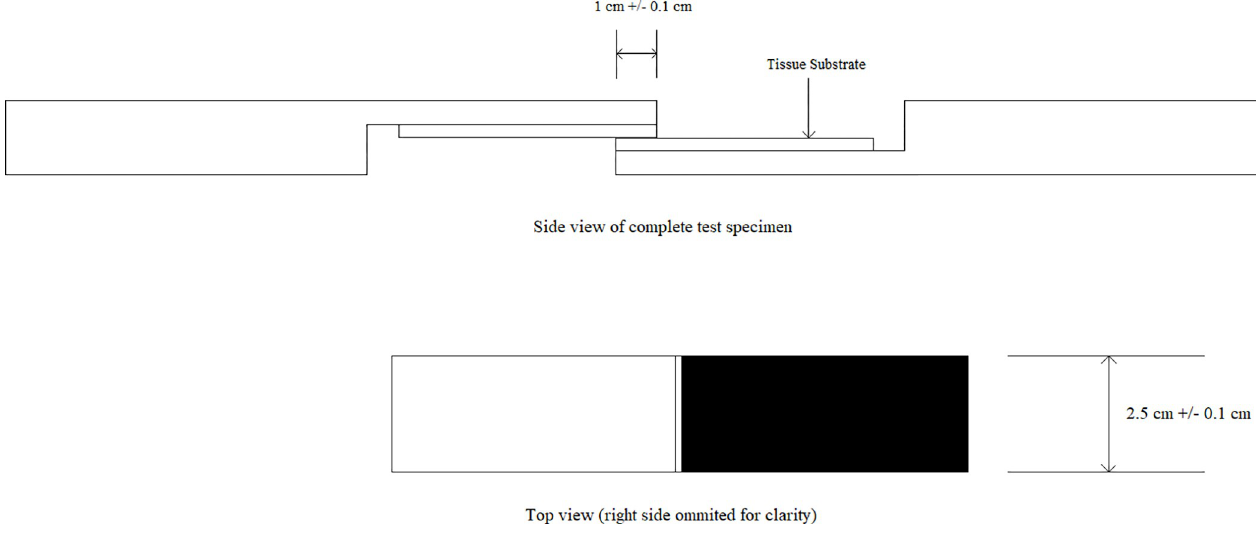
Fig 7. Test system